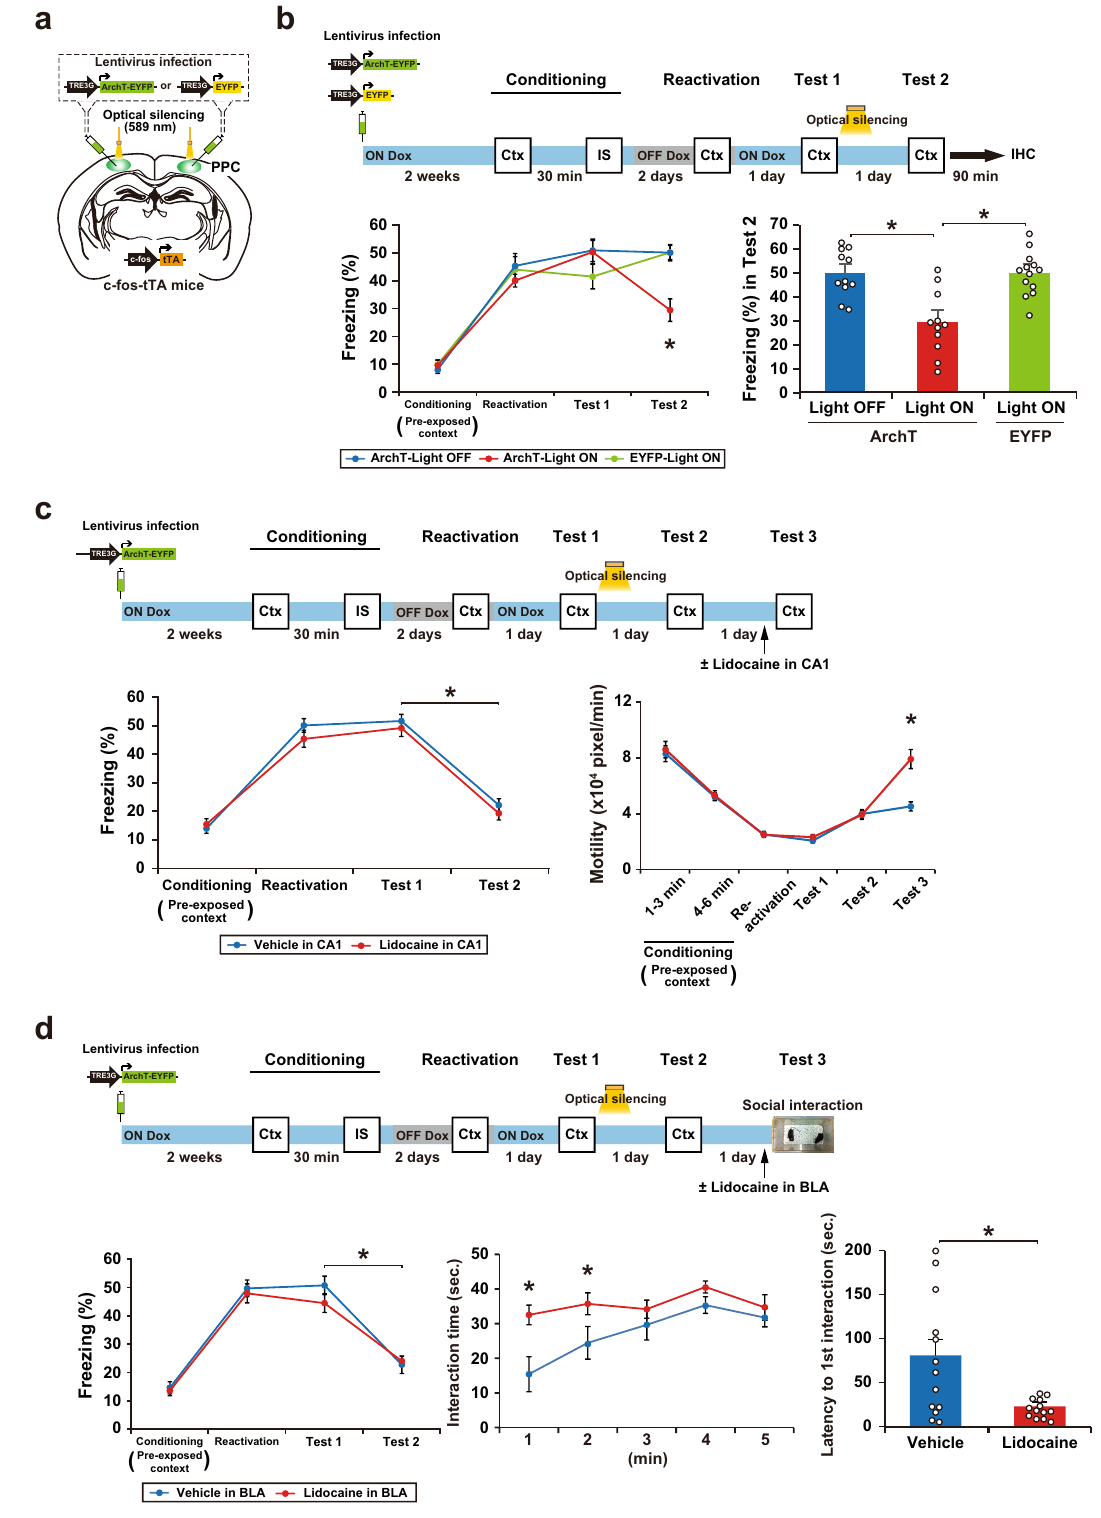
anesthetized with a pentobarbital solution (80 mg/kg of body weight; intraper- itoneal injection), and the fully anesthetized mice were placed in a stereotactic apparatus (David Kopf Instruments, Tujunga, CA, USA). The male C57BL/6J and c-fos-tTA transgenic mice were injected with LV or AAV to the PPC, CA1, or BLA. The positions (in mm) were as follows: (i) − 2.0 AP, ±1.5ML from bregma, − 0.5 DV from the brain surface for the PPC; (ii) − 2.0 AP, ±1.5 ML, − 1.5 DV from bregma for the CA1; (iii) − 1.5 AP, ±3.3 ML, − 4.9 DV from bregma for the BLA. Borosilicate glass capillaries (G100T-4, outer diameter: 1.0 mm; inner diameter: